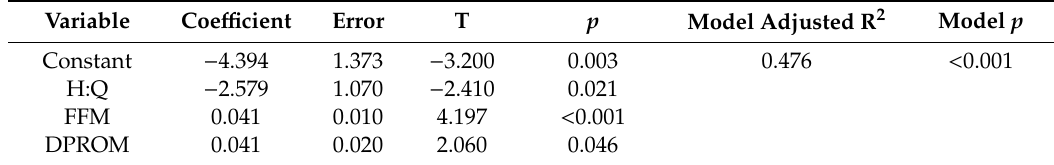
Table 8. Regression Table for Stepwise Multiple Linear Regression Analysis for nGRFy from Predictor